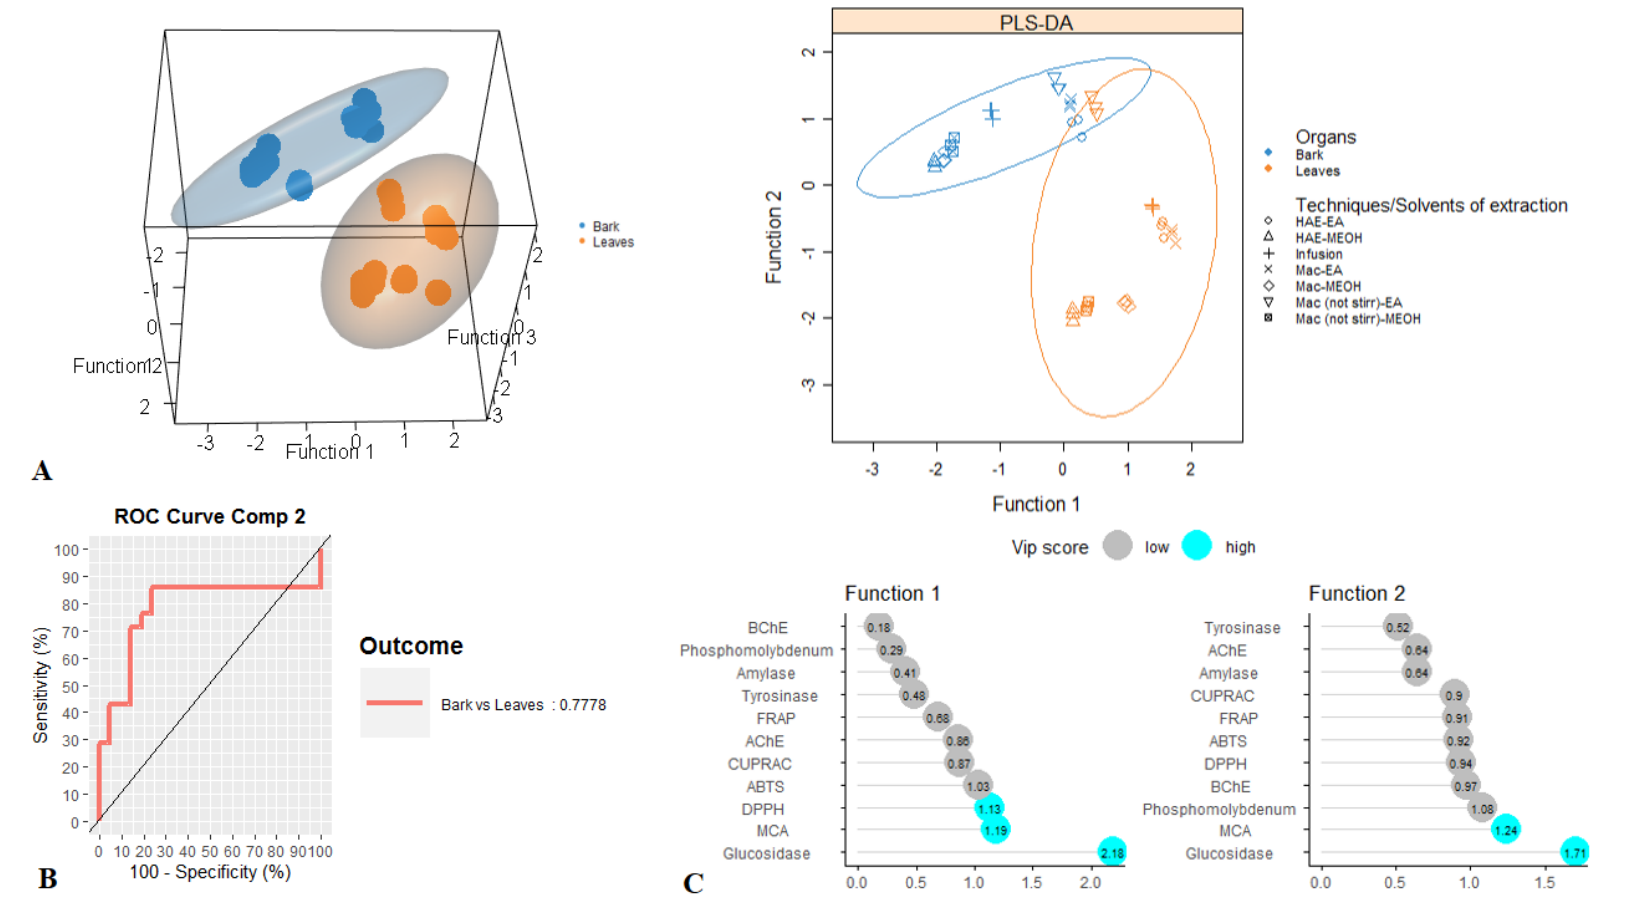
Figure 3. Discrimination between leaves and bark samples through PLS-DA. ( A ). Three- and two-dimensional score plots. ( B ). Area Under the Curve average using one-vs-all comparisons. ( C ). Biological activities assays explaining the largest part of the variance between the two organs.